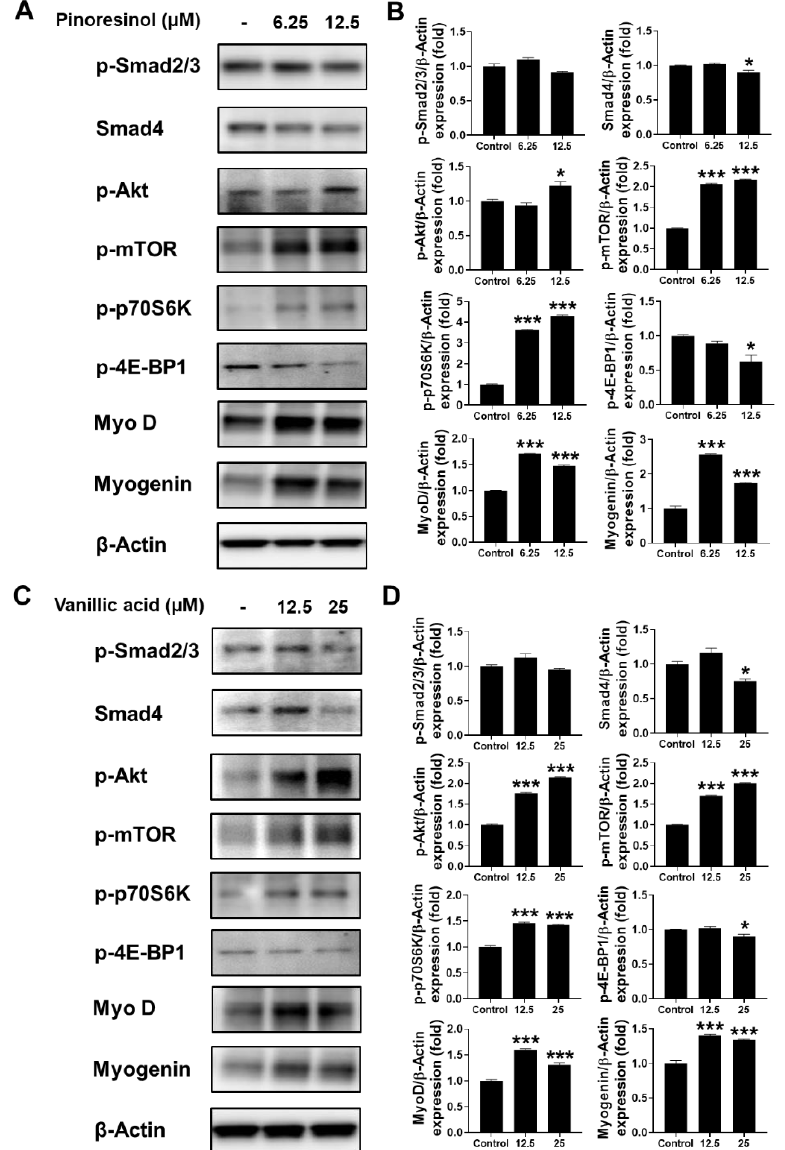
Figure 4. Activated myogenesis by pinoresinol and vanillic acid in mouse myoblast cell line. Western blot using C2C12 cells subjected to different concentrations of pinoresinol ( A ) or vanillic acid ( C ) to assess TGF- β signaling (p-Smad2/3 and Smad 4), IGF-1 signaling (p-Akt, p-mTOR, p-p70S6K, and p-4E-BP1), MyoD, and myogenin. β -Actin was used as the loading control. The relative band intensity of proteins to that of β -actin is expressed as the fold change compared to the control (no treatment) for pinoresinol ( B ) or vanillic acid ( D ). Data are expressed as mean ± SEM, obtained from at least triplicate determinations. * and *** indicate p < 0.05 and p < 0.001 by one-way ANOVA, re- spectively.